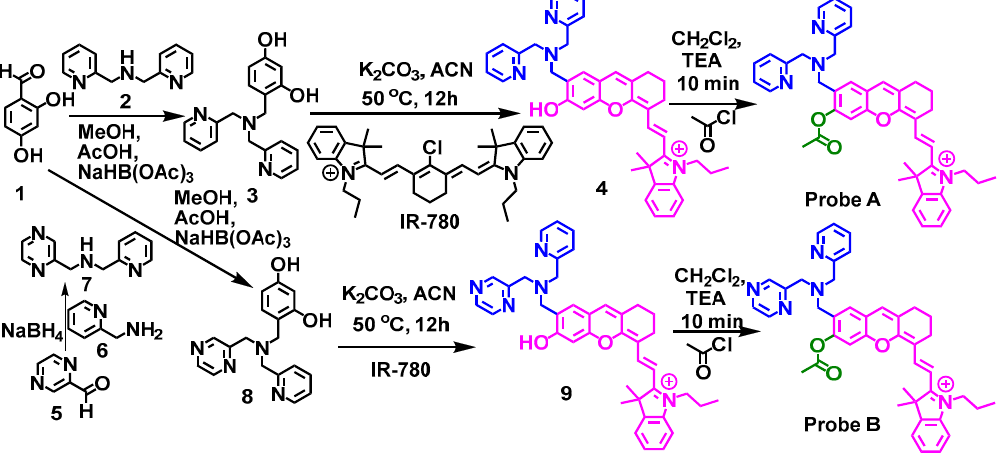
Table 1. Optical properties of intermediates and fluorescent probes A and B